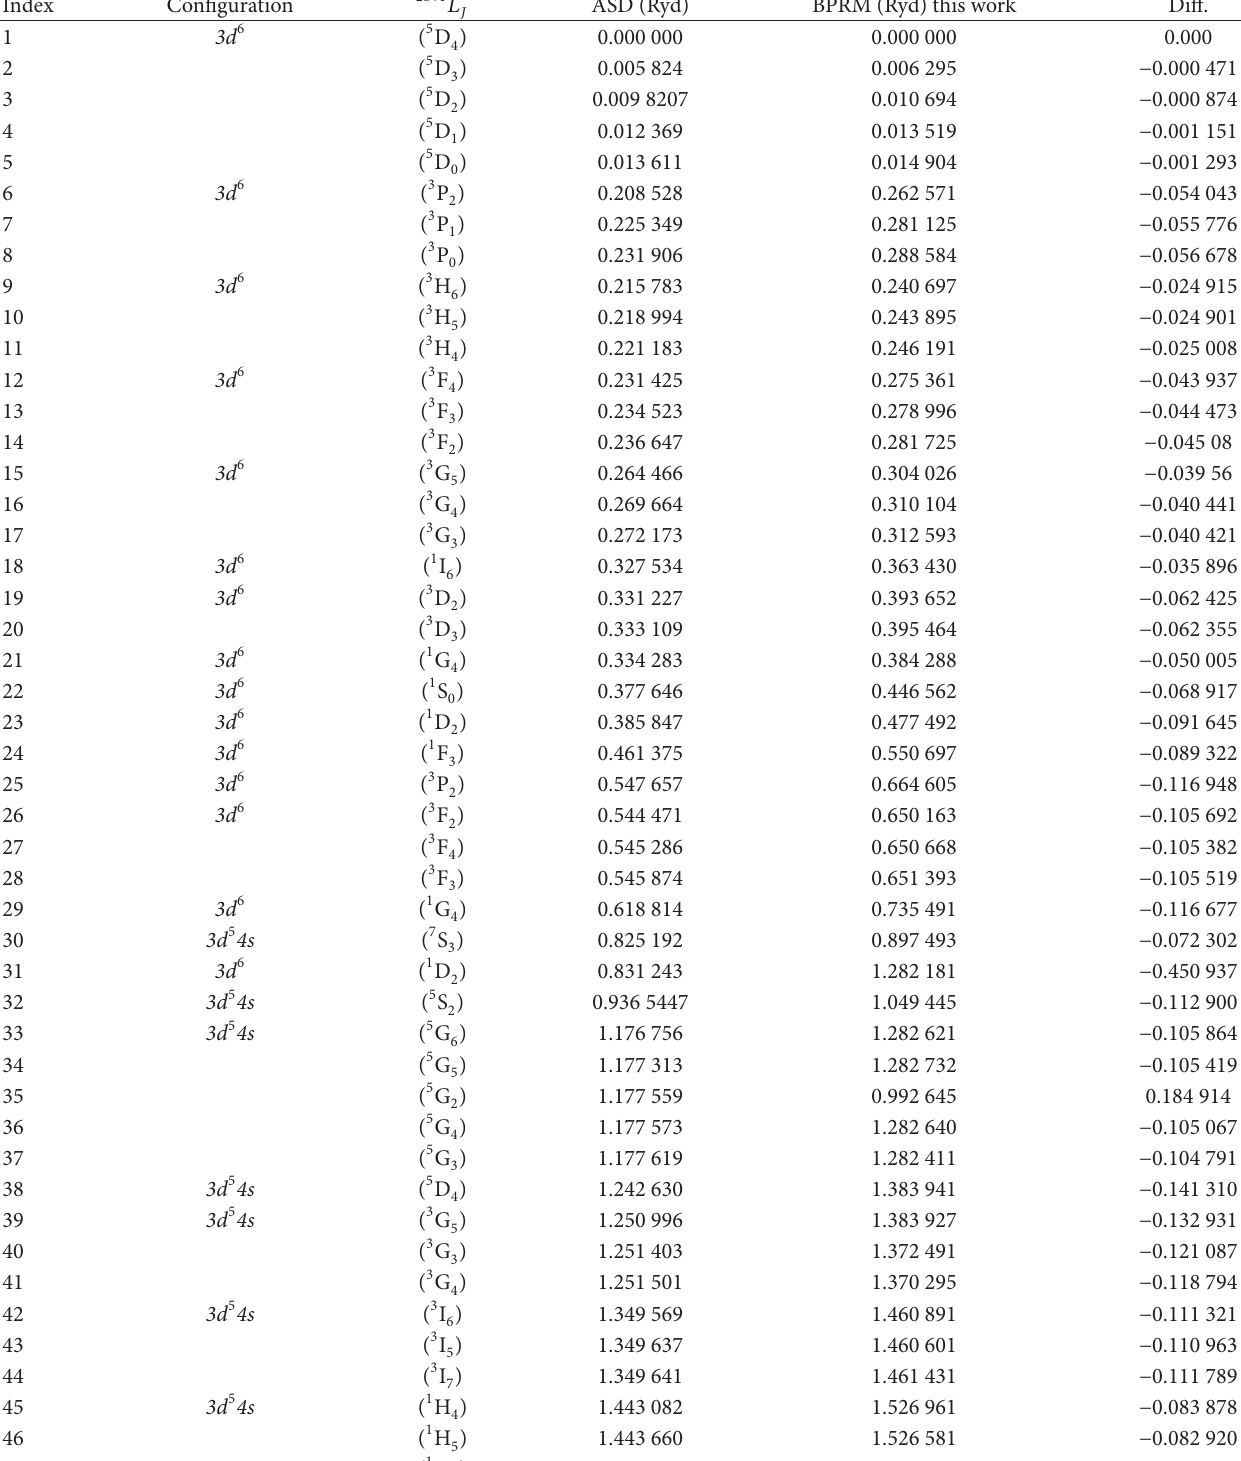
T 1: Comparison between the calculated theoretical levels energy and the experimental data from ASD, in Rydberg